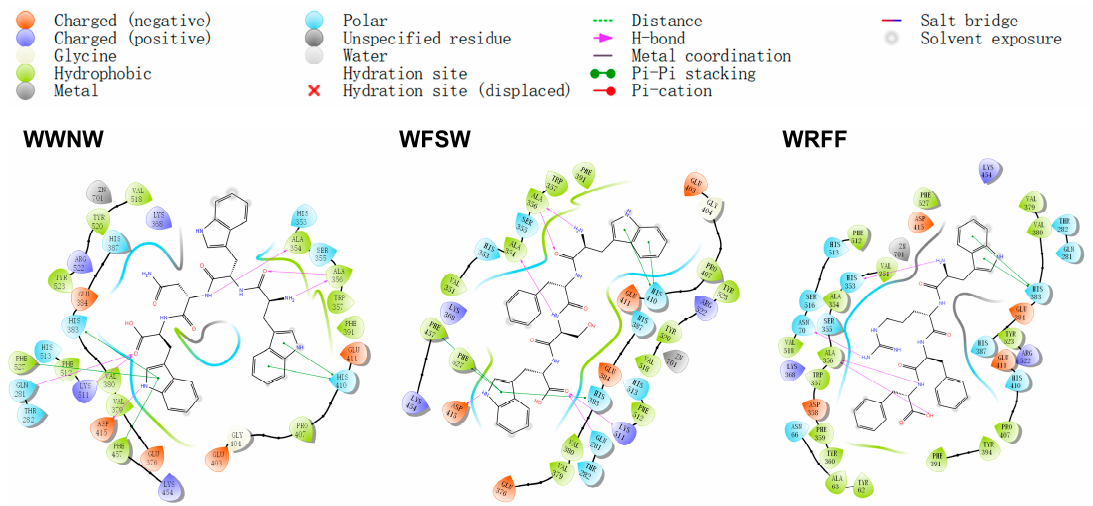
Figure 2. The 2D interaction map of ACE with the top three tetrapeptides.